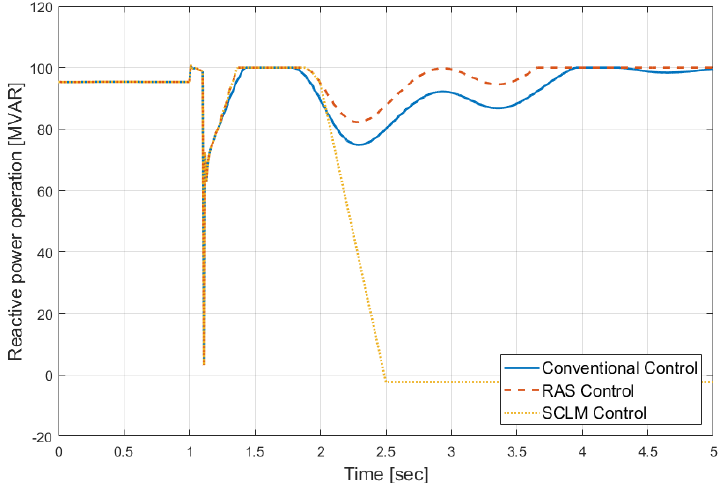
Figure 13. Reactive power operation change in the line overload case at the rectifier end.